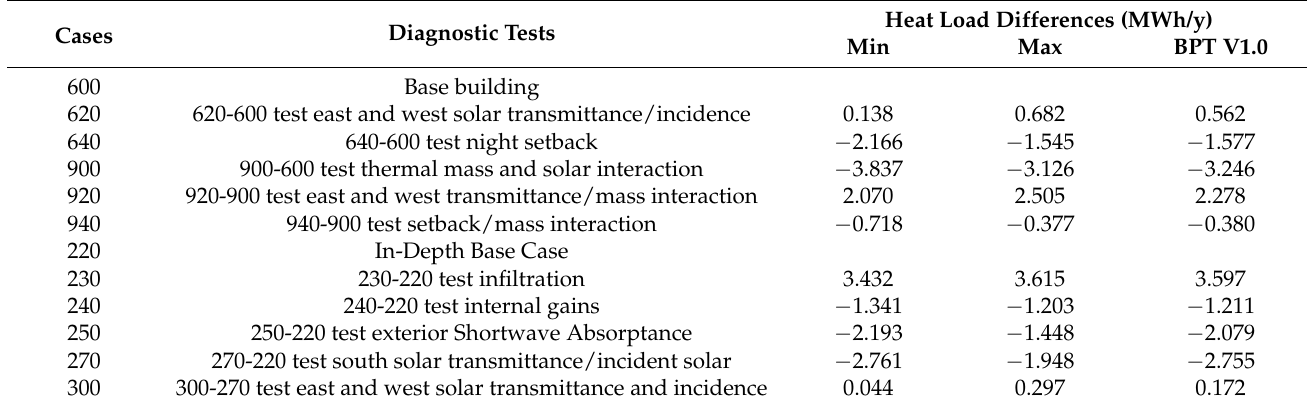
Figure 5. Annual heating load for in-depth test cases. Table 6. Diagnostic tests and sensitivity